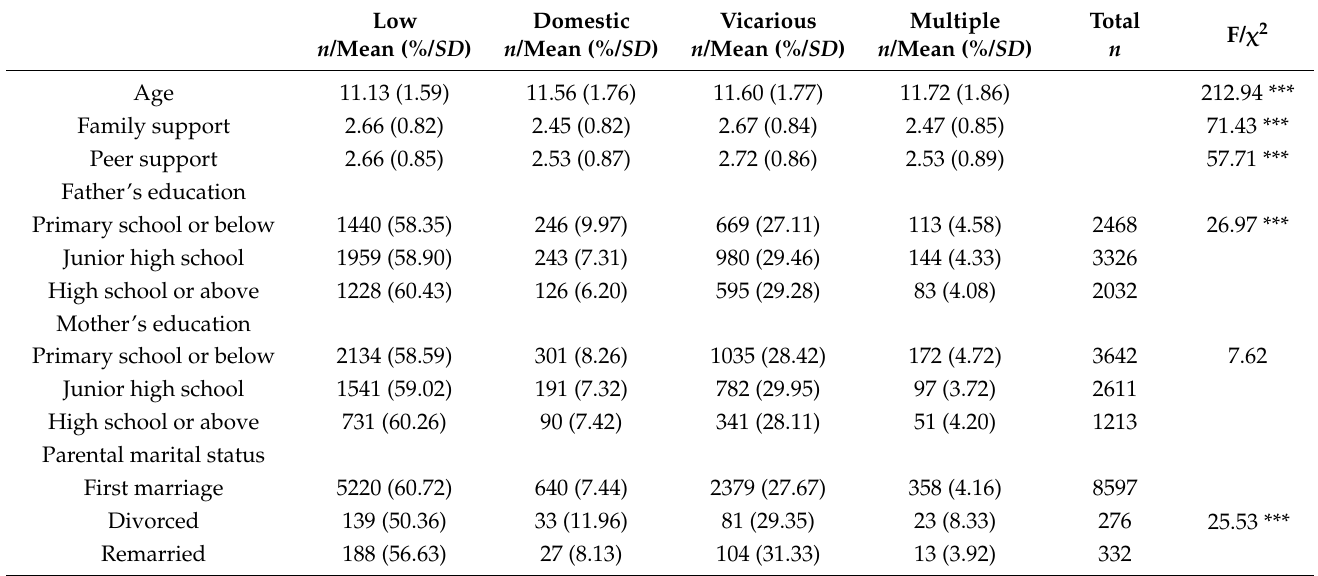
Table 3. Demographic variables of males according to classes of CTEs ( N =